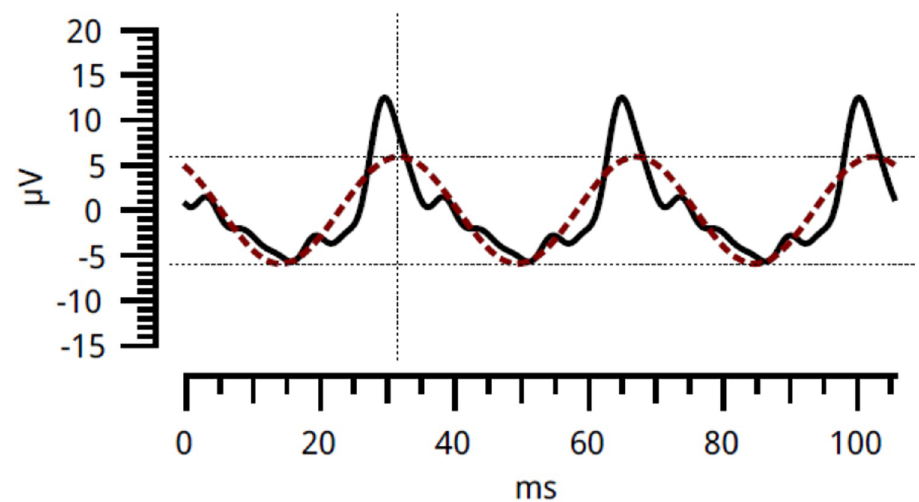
Fig 1. Examples of the flicker ERG recorded by the RETeval system. Two flicker ERGs of the fundamental component (colored dotted line) and the reconstructed flicker ERG waveform using the first eight harmonics (solid black line) are presented by this